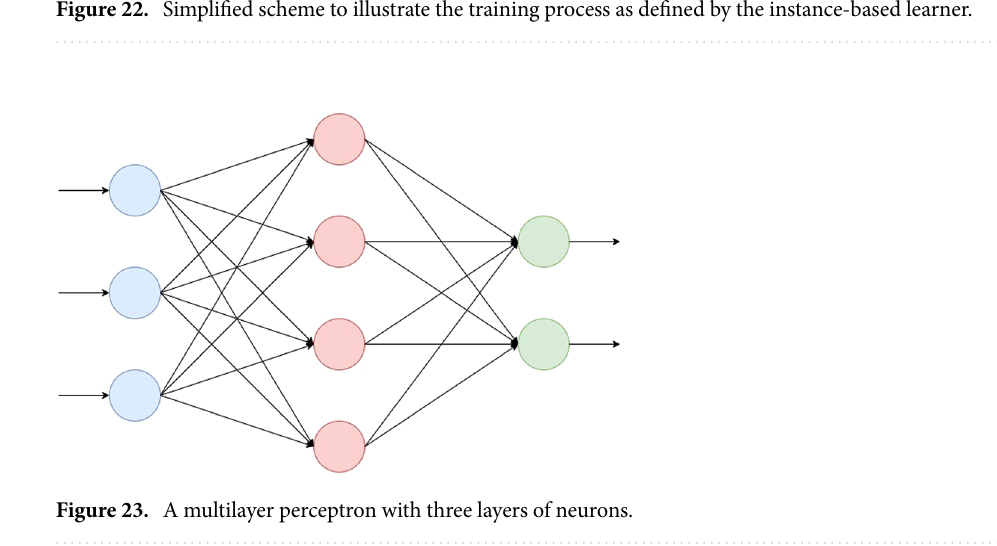
Figure 22. Simplified scheme to illustrate the training process as defined by the instance-based learner.